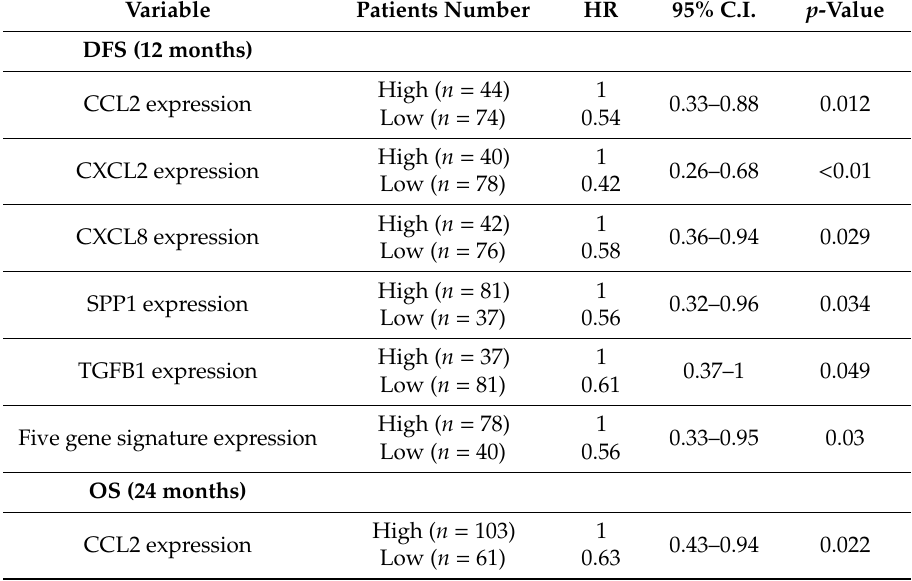
Figure 6. An immune-related gene signature, based on GASC study, could predict GBM prognosis. The prognostic value of CCL2, CXCL2, IL8, SPP1 and TGFB1 was assessed independently in the TCGA-GBM RNA-seq dataset and was represented by Kaplan-Meier plots. Both the ( A ) Overall Survival (OS, left panel) and the ( B ) Disease-Free Survival (DFS, right panel) were evaluated. Afterwards, the analysis was repeated considering the five-genes signature (median expression). Patients were stratified based on the optimal cut-point and data were censored at 24 months for OS and at 12 months for DFS. Table 5. Univariate analysis in terms of disease-free survival (DFS) and overall survival (OS). The Cox regression analysis was performed for the five genes considered either singularly or included in a five-gene signature. Hazard ratios and confidence intervals were calculated using the survival R / Bioconductor